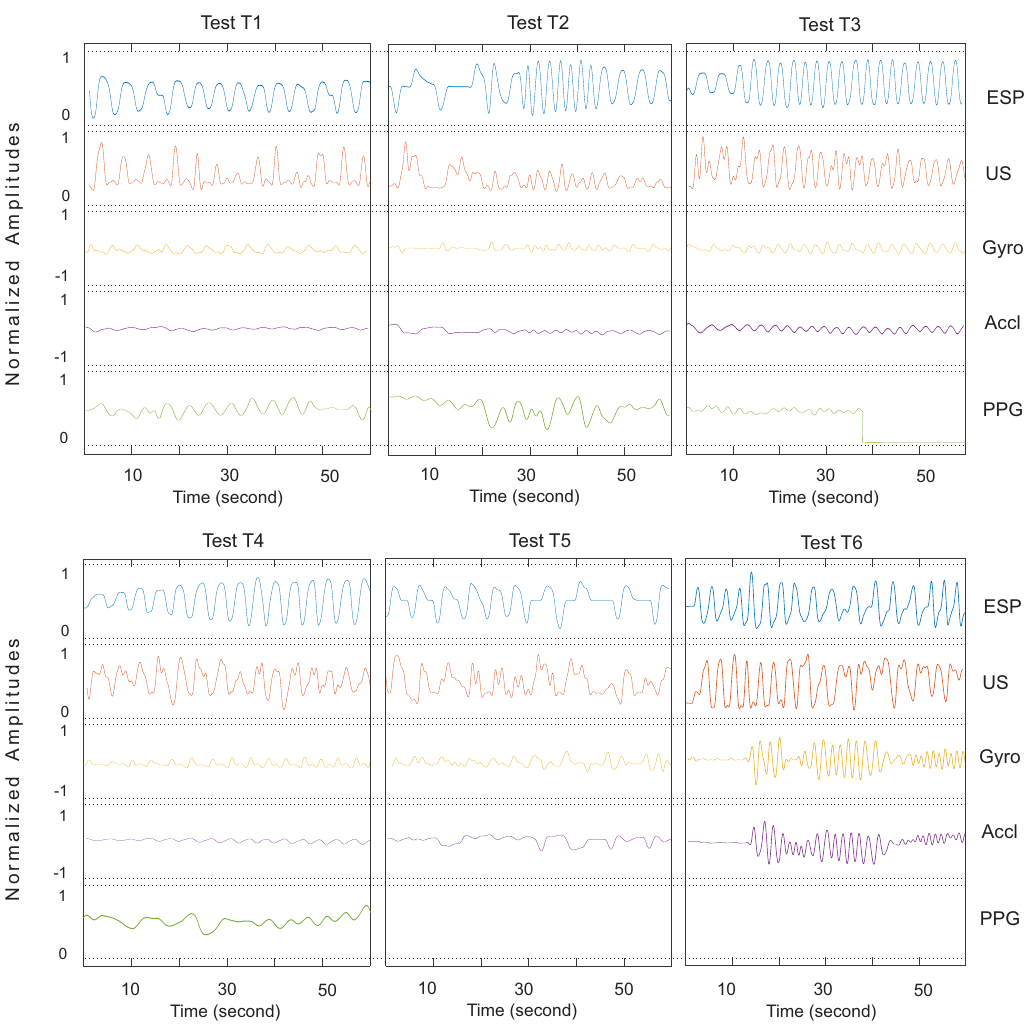
Figure A4. Respiratory waveforms of Subject 5. The PPG sensor was detached from the subject’s finger in the last 15